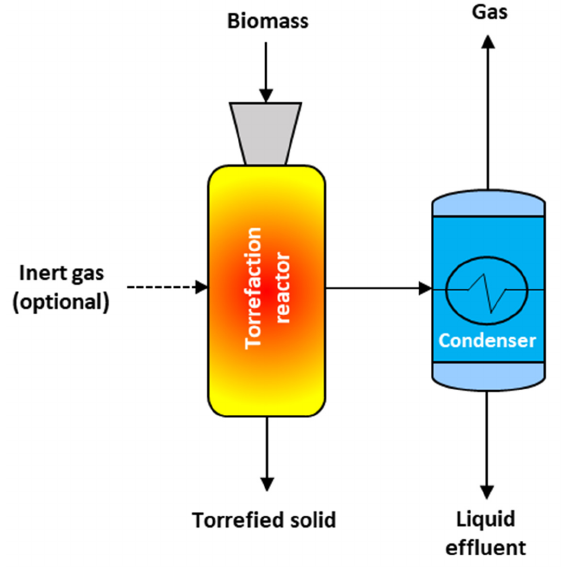
Figure 1. Typical process representation of torrefaction of biomass. Table 1. Summary of notable works on torrefaction of waste biomass.